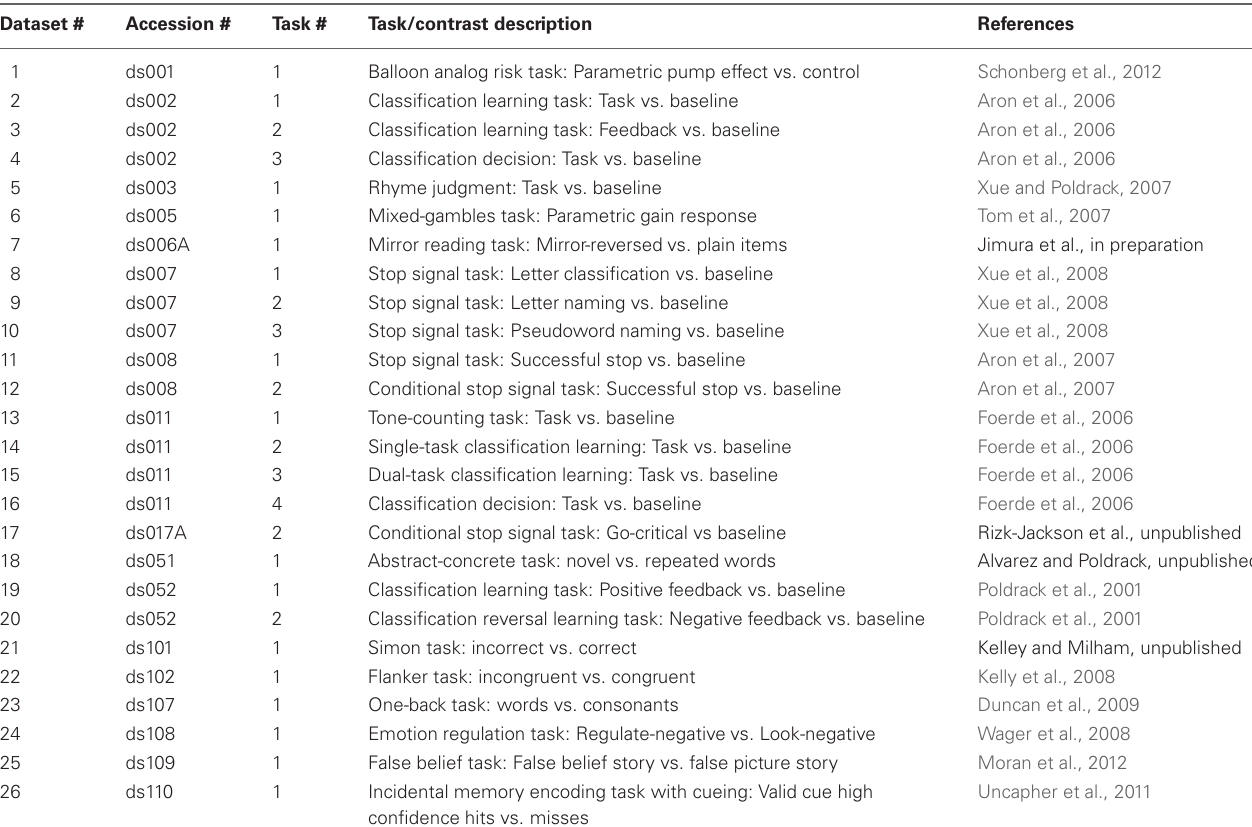
Table 2 | List of datasets used in the preliminary analyses